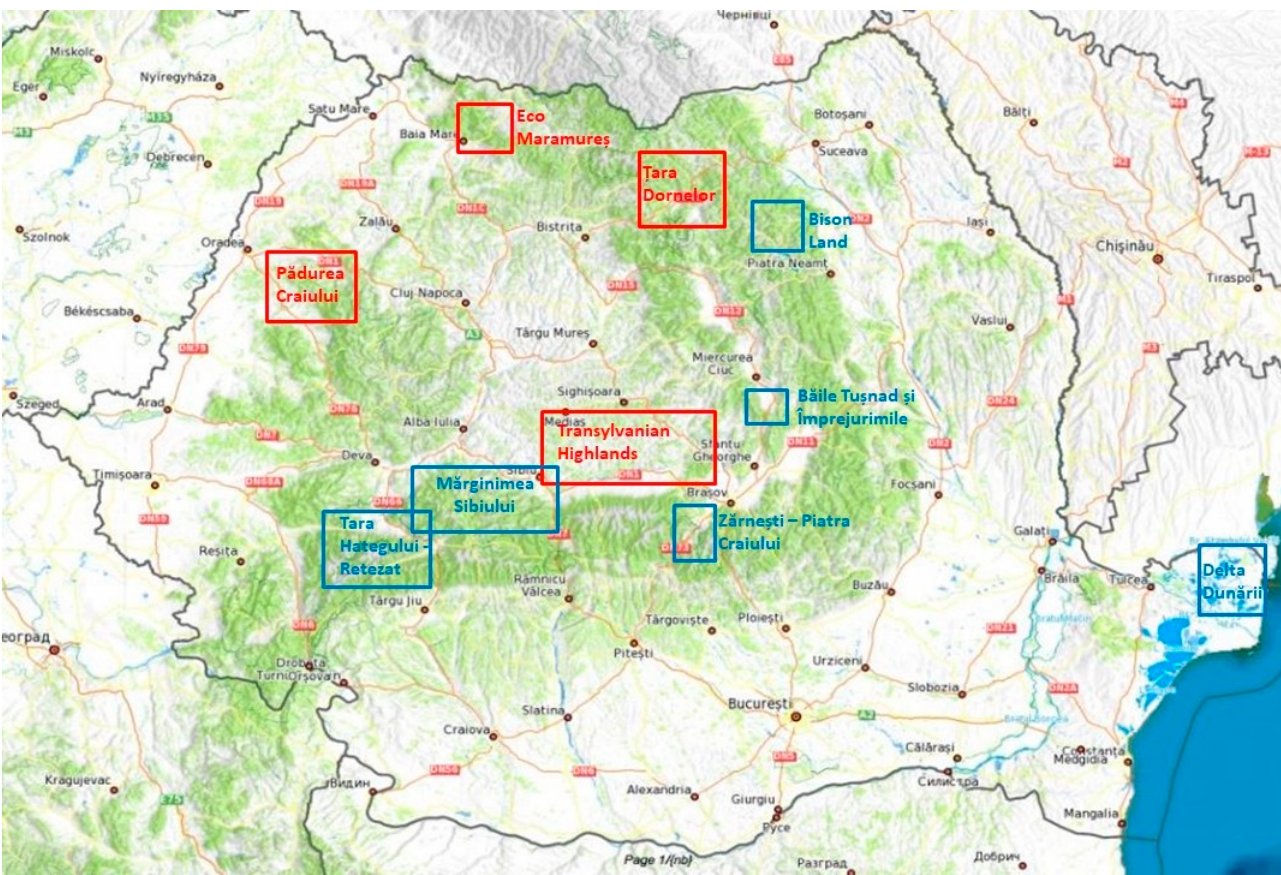
Figure 1. The geographical location of the Romanian ecotourism destinations. Source: [69].